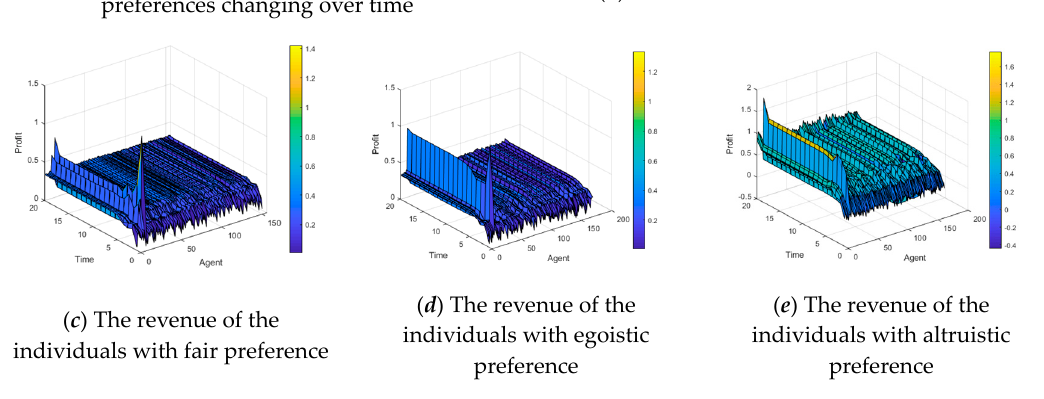
Figure 27. Specific preference analysis of a real case.